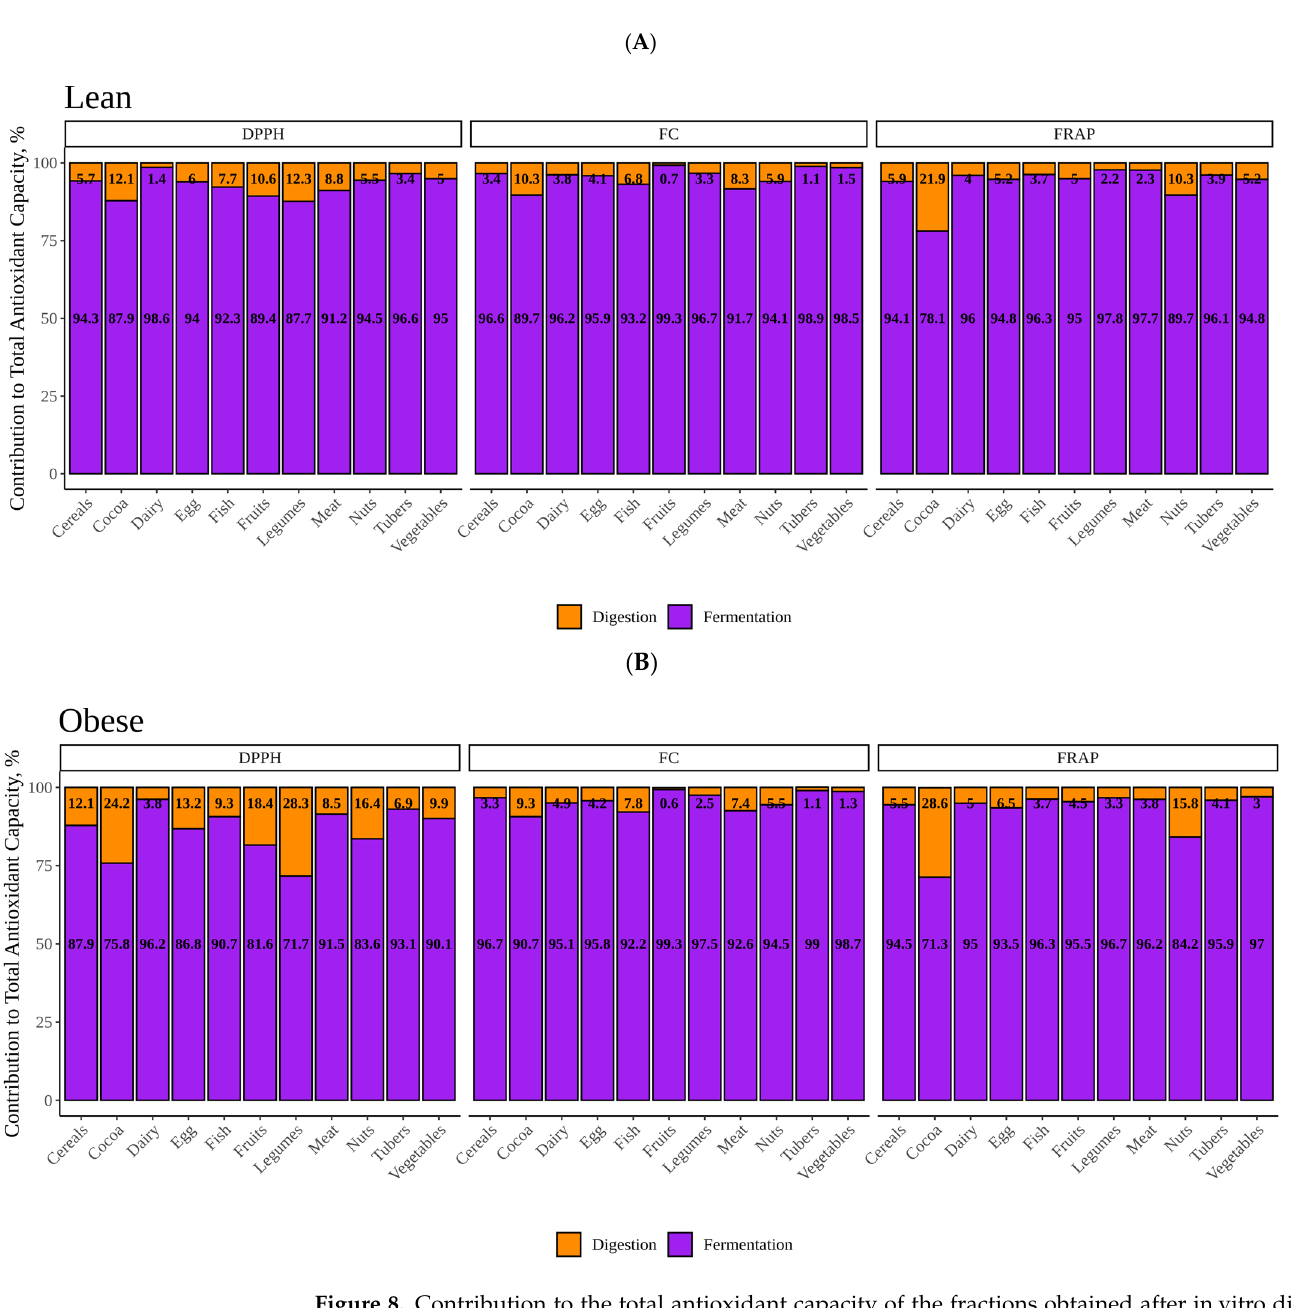
11 of 19 Figure 7. Comparison between the antioxidant capacity of different food groups after in vitro fermentation with fecal material from obese and lean children. DPPH expressed as mmol Trolox equivalents/kg(L) of food; Folin–Ciocalteu (FC) expressed as mg equivalents of gallic acid/kg(L) of food; FRAP expressed as mmol Trolox equivalents/kg(L) of food. Diamonds represent the mean